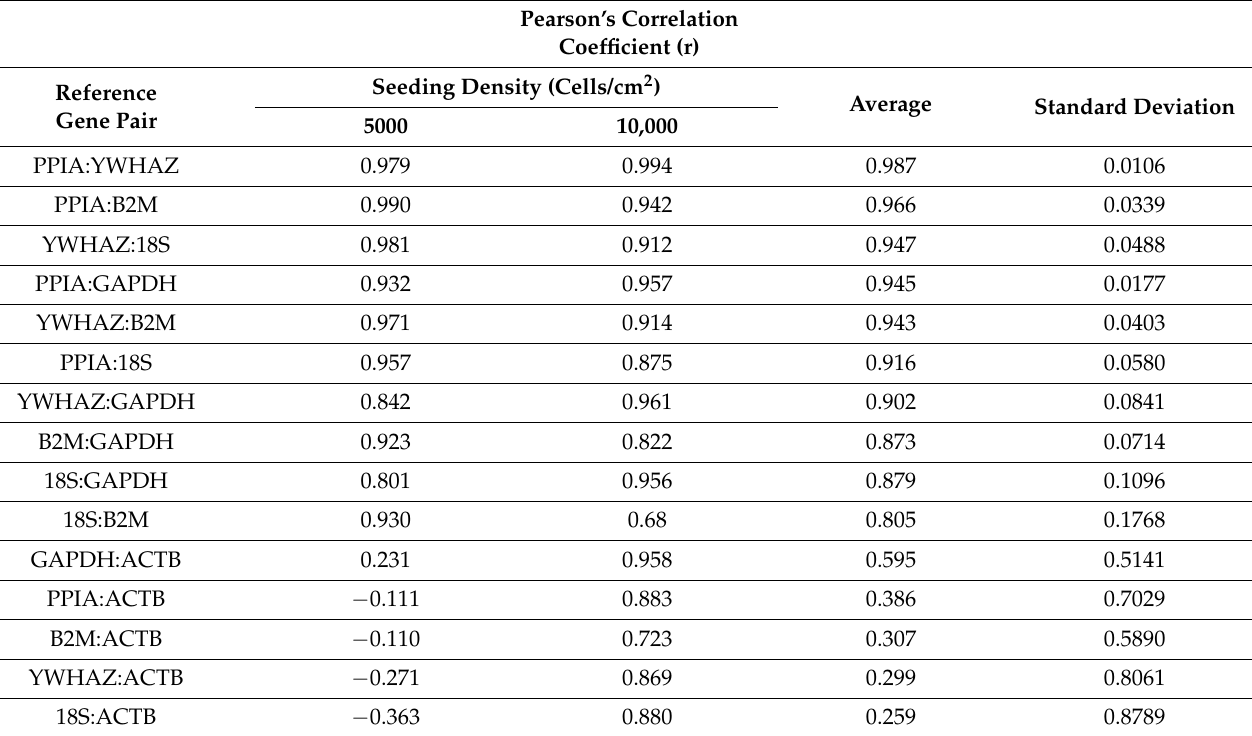
Table 3. Pearson’s correlation coefficient (r) values for each potential reference gene pair as deter- mined by BestKeeper. Pearson’s